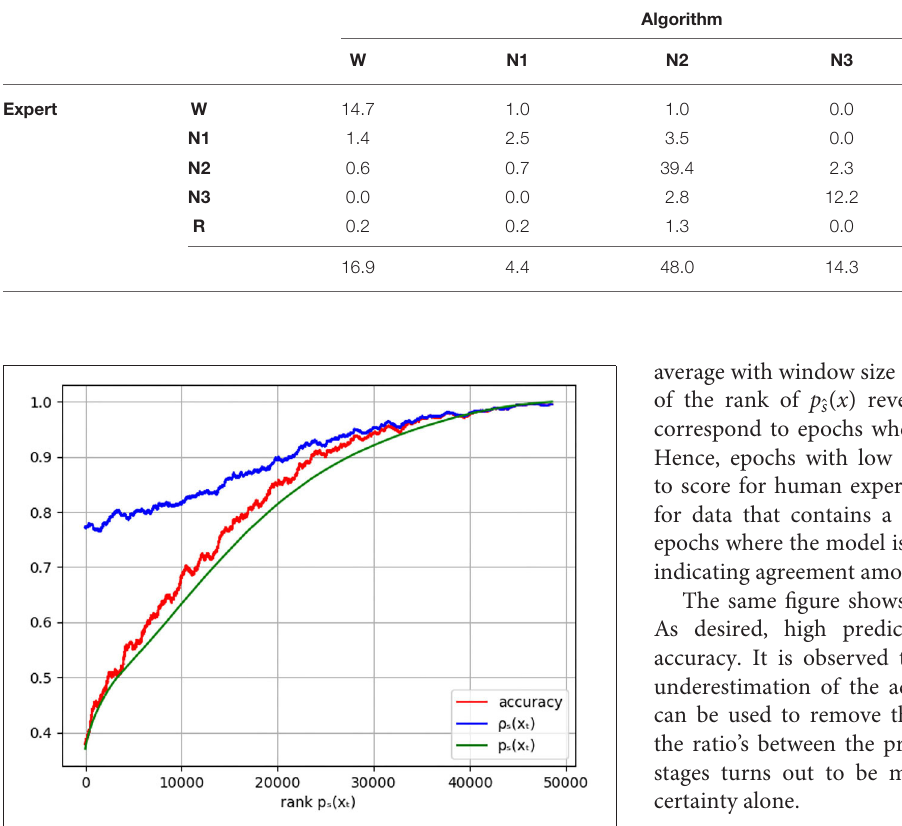
FIGURE 2 | Plot of the moving average of the accuracy (red), the experts’ certainty ρ ¯ s ( x t ) (blue), and the model certainty p ˆ s ( x t ) (green) in function of the rank of p ˆ s ( x t ). The accuracy is given by the weighted agreement between the predicted sleep stage and the experts’ labels with weights such that every epoch contributes equally, independent of the number of experts’